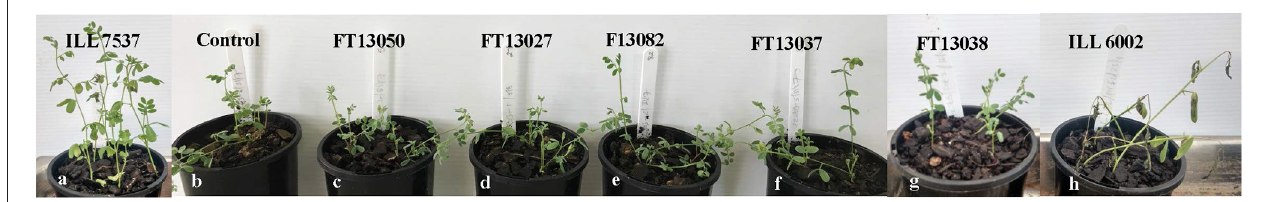
FIGURE 1 | Response of wild Lens ILWL 180 to five isolates. (a,h) Response of resistant and susceptible controls ILL 7537 and ILL 6002, respectively to a representative isolate FT13038 21 days post inoculation. (b) control pot of wild Lens ILWL 180. (c–g) Response of wild Lens ILWL 180 to isolates FT13050, FT13027, F13082, FT13037 and FT13038 21 days post inoculation